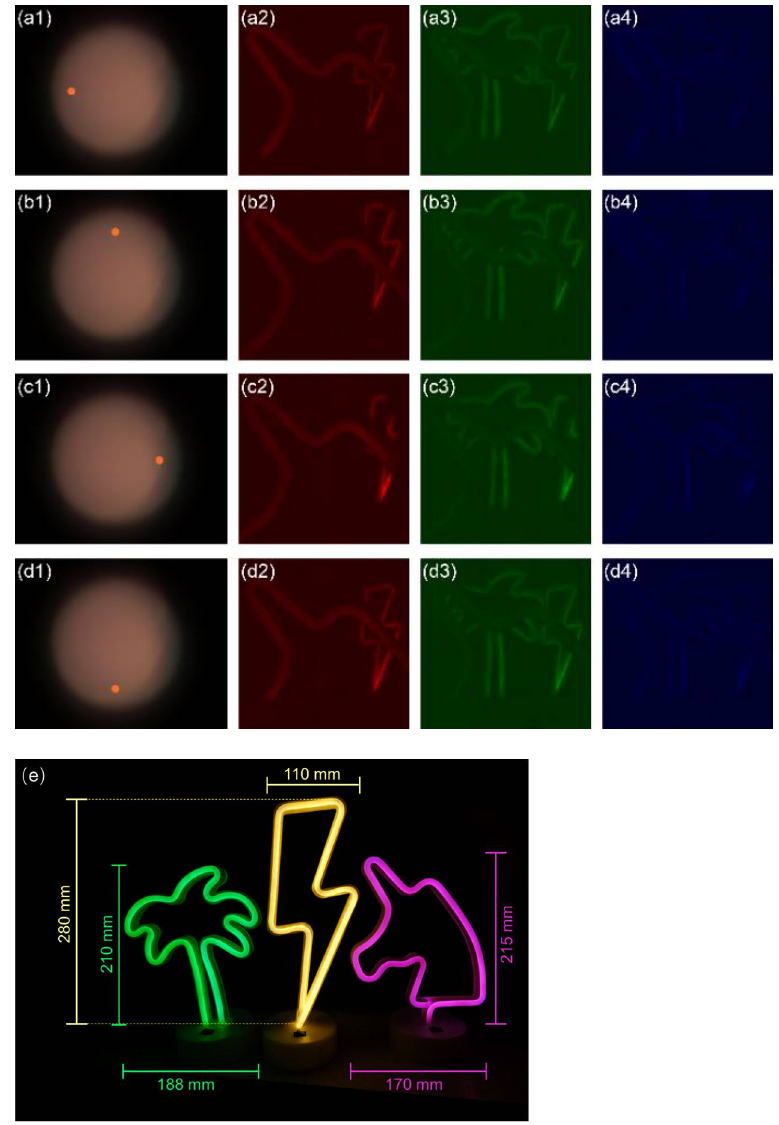
Figure 8. ( a1 – d1 ) The positions of single-pixel detectors (orange dots); ( a2 – a4 ) the perspective images reconstructed by the leftmost single-pixel detector; ( b2 – b4 ) the perspective images reconstructed by the topmost single-pixel detector; ( c2 – c4 ) the perspective images reconstructed by the rightmost single-pixel detector; ( d2 – d4 ) the perspective images reconstructed by the bottommost single-pixel detector (see Visualization 3); ( e ) the physical size of the self-luminous objects.